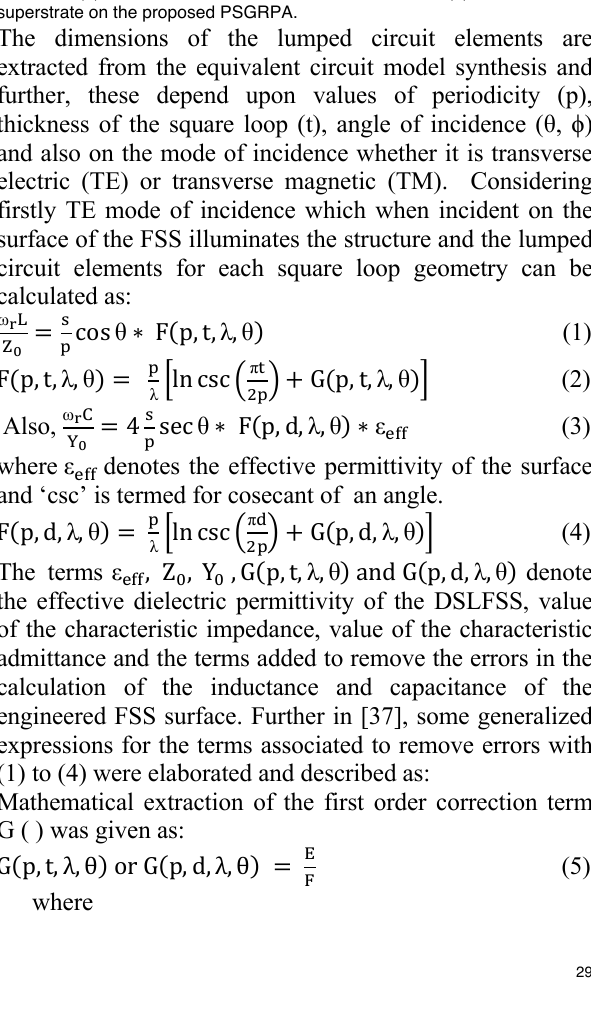
FIGURE 2: .DSLFSS unit cell and DSLFSS as a superstrate on the proposed PSGRPA (a) schematic of the DSLFSS unit cell, and (b) DSLFSS as a superstrate on the proposed